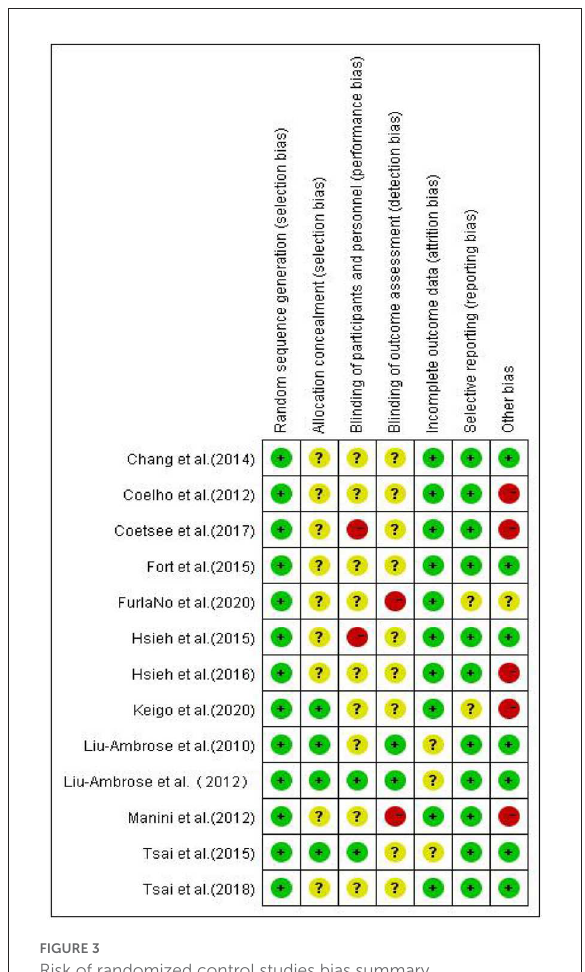
FIGURE3 Risk of randomized control studies bias